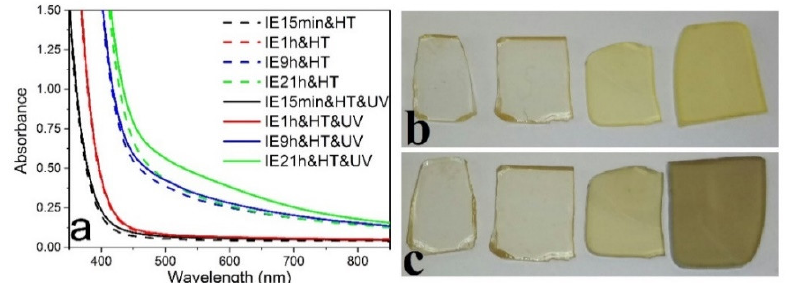
Figure 9. ( a ) Absorbance spectra of the ion-exchanged and heat-treated at 500 ◦ C for 9 h PTR-Br glass samples before and after UV irradiation with a mercury lamp. ( b ) Photo of the samples before and ( c ) after the UV irradiation.